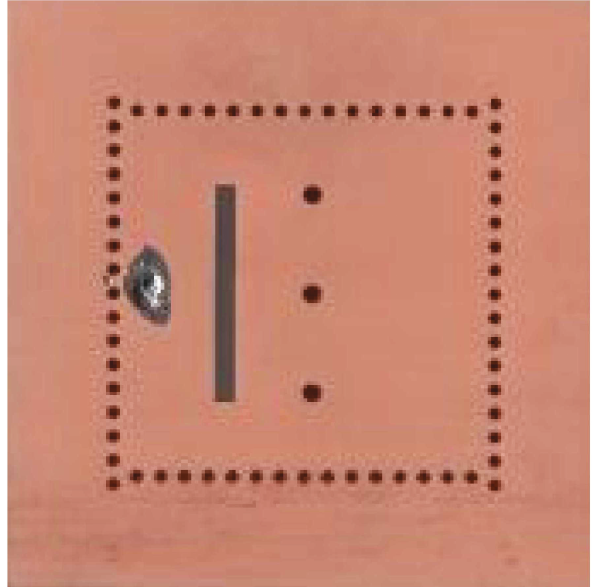
Figure 10: Photograph of the fabricated